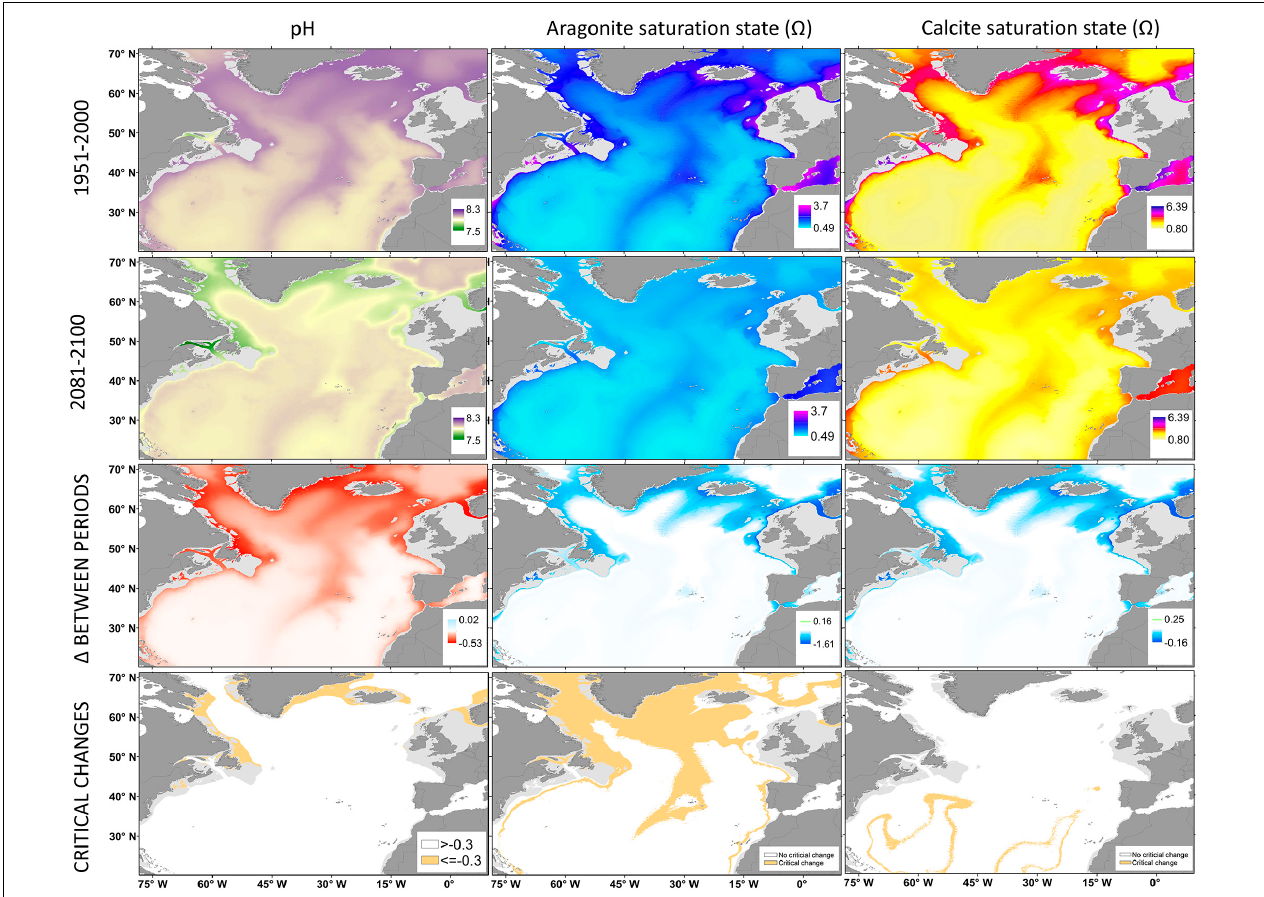
FIGURE 4 | Present and future scenarios predicted for pH and aragonite and calcite saturation states at the seafloor in the North Atlantic Ocean. Changes, as increment ( (cid:49) ) between periods, were measured as the difference between present-day and the modeled conditions by 2100. Areas with critical changes in the values of a given water mass property are